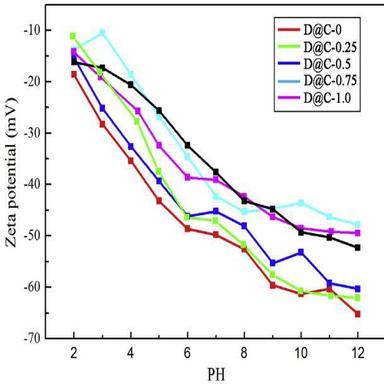
Variation of zeta potential with pH for the ND and D@C-x.